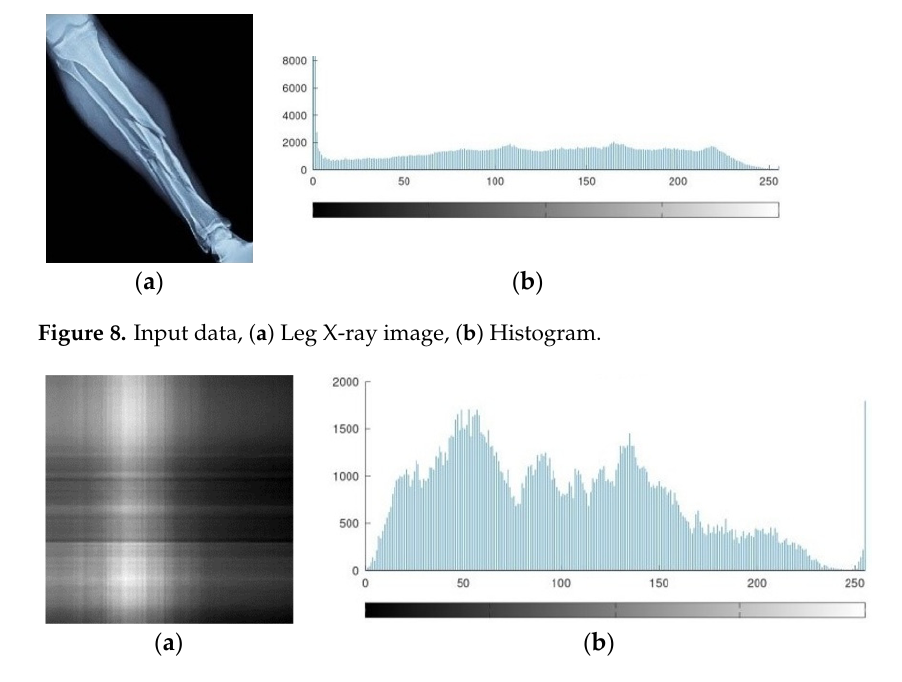
58 Table 12. Comparison of AES-FJMKE and AES-RS for Spartan 6. FPGA Performances 81 Table 13. Comparison of AES-FJMKE and AES-MPPRM for Kintex 7. Performances